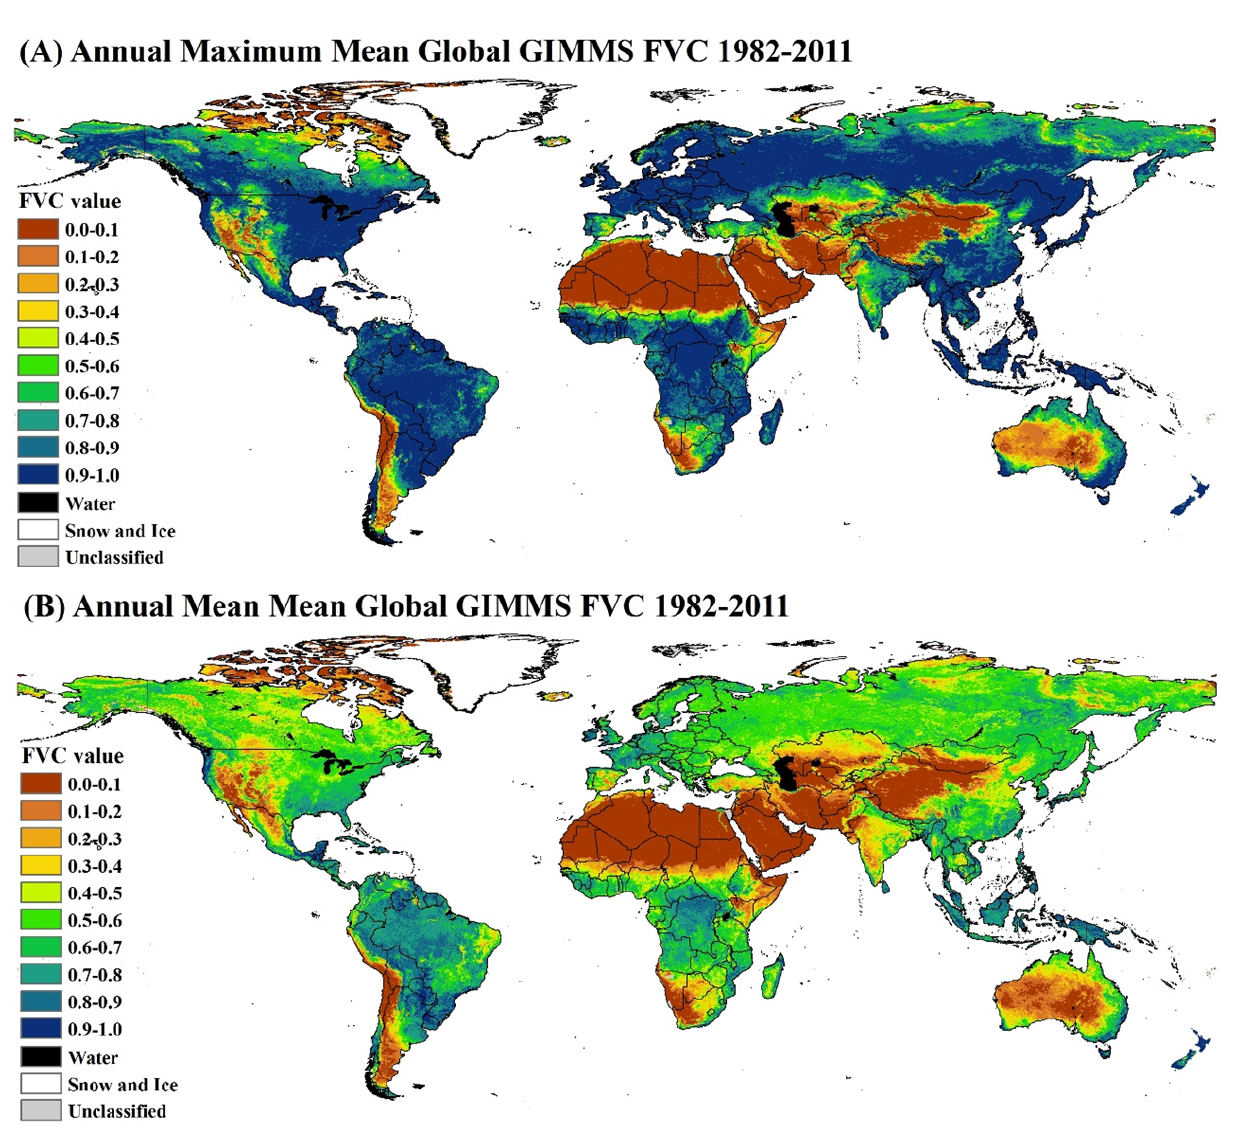
Figure 6. ( A ) Annual maximum mean FVC image computed from 1982 to 2011. ( B ) Annual mean FVC image computed from 1982 to